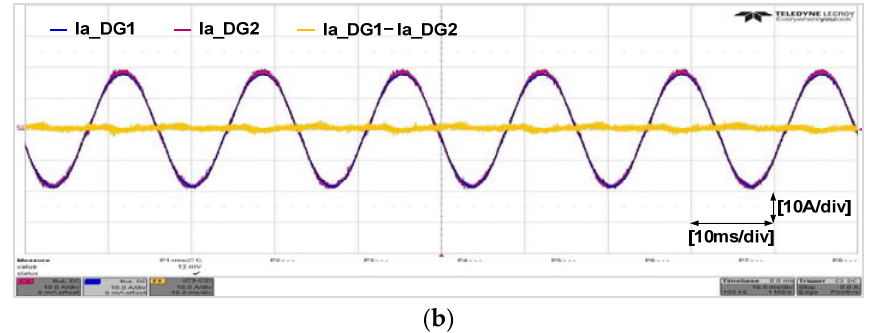
Figure 21. Experimental Results of DG currents and Circulating current: ( a ) Existing droop ( b ) Proposed droop.